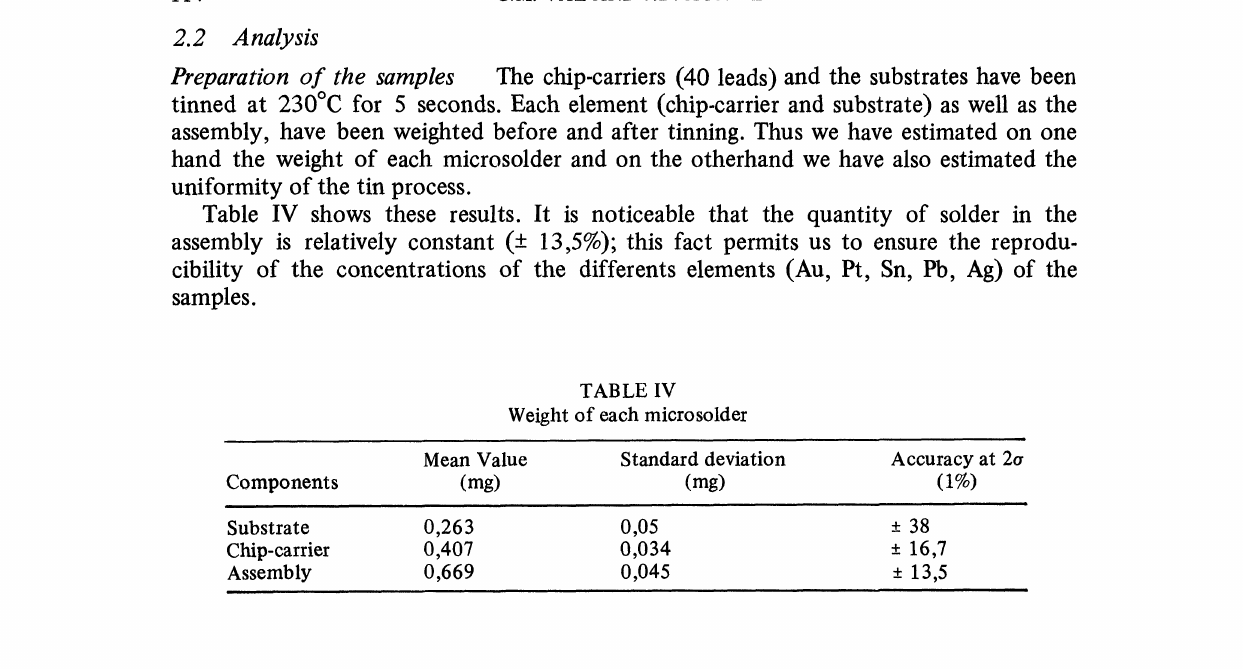
Mean Value Standard deviation Accuracy at 2r